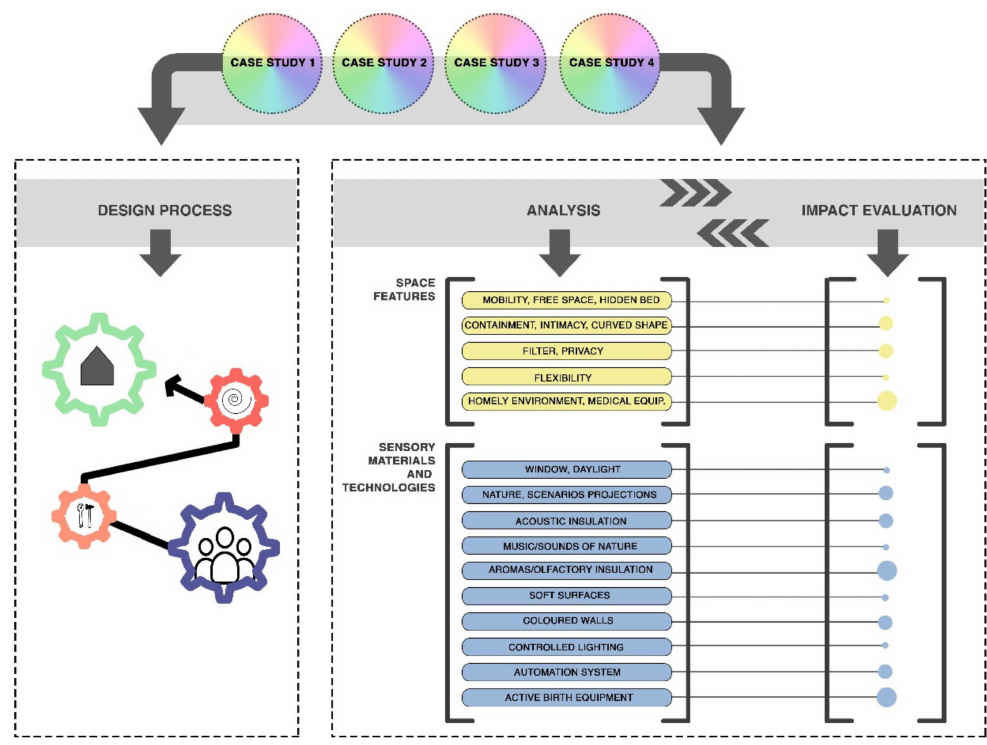
Figure 3. Methods for the analysis and the evaluation of case